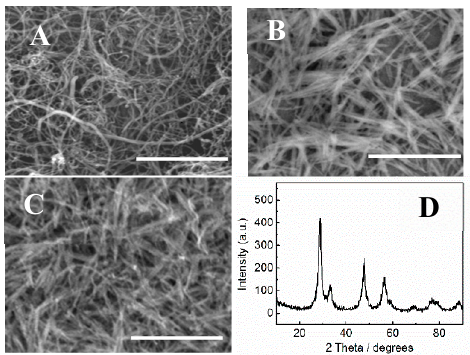
Figure 1. Scanning electron microscope (SEM) images of MWCNTs ( A ), CeO 2 nanorods ( B ), and MWCNTs-CeO 2 nanorods ( C ). Scale bar: 1.0 µ m. The XRD of CeO 2 nanorods ( D ).